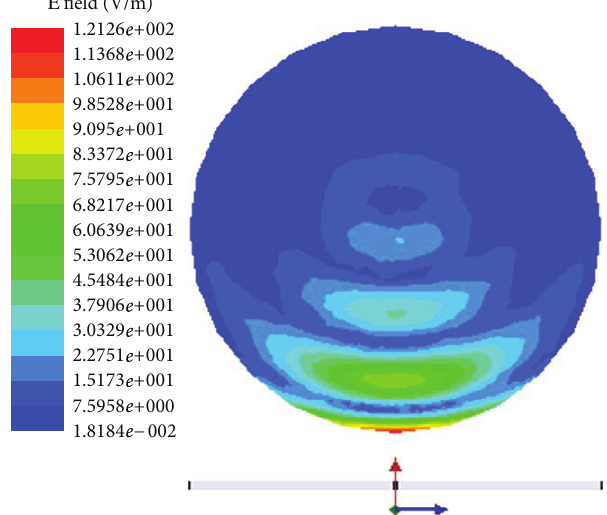
F 8: �-�eld strength in brain tissue at 900���.